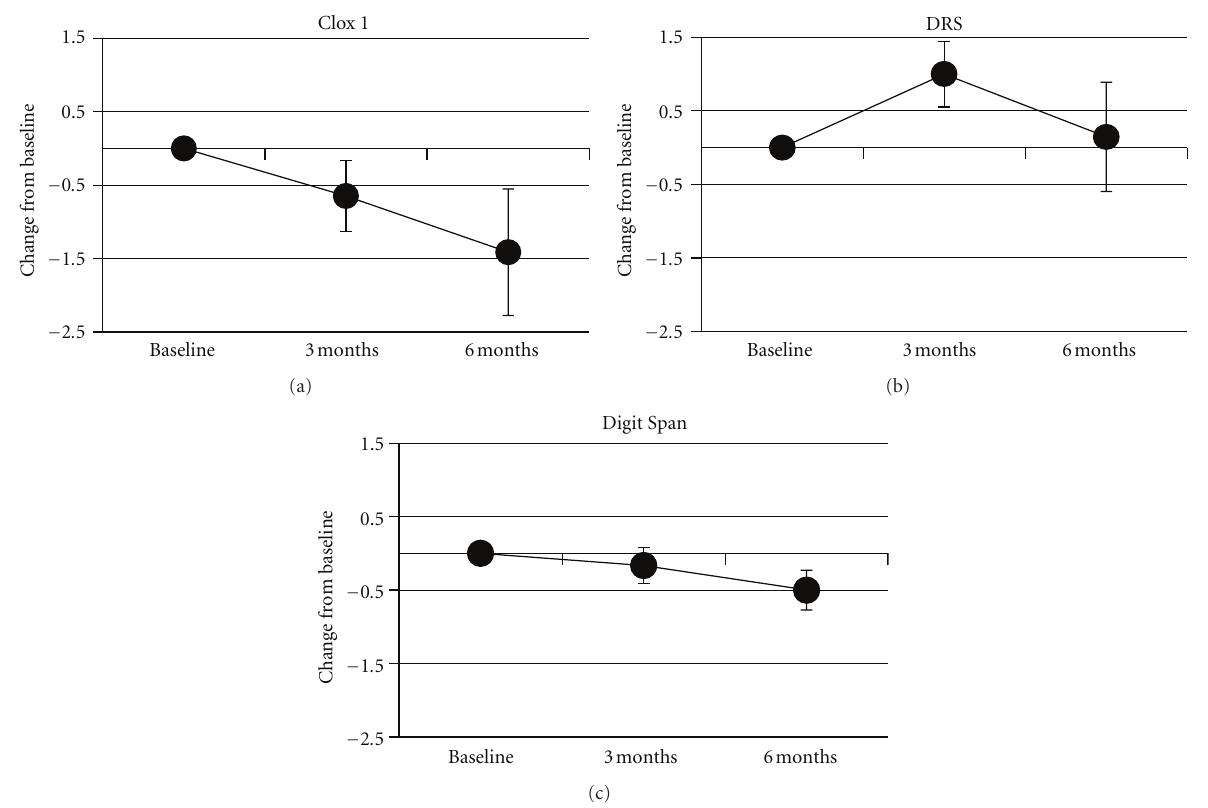
Figure 1: Performance on Clox 1, WAIS Digit Span, and the DRS. The change in value for each individual’s performance on each test was calculated at 3- and 6-months. Values represent the mean change ( ± standard error of the mean). The mean performance at baseline was normalized to 0 for each test to allow comparison among tests. Values for Clox 1 di ff ered statistically from baseline by 3 months. Values for the Digit Span did not di ff er statistically from baseline until 6 months. Values for the DRS did not di ff er statistically from baseline at either time